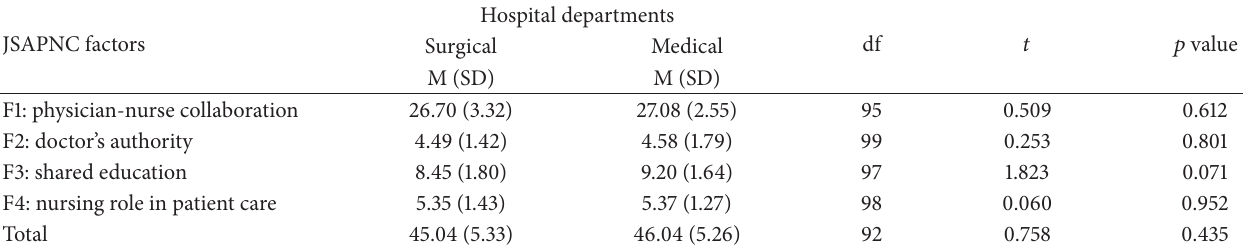
Table 5: Attitude of physicians toward nurse physician collaboration factors according to place of work. JSAPNC factors